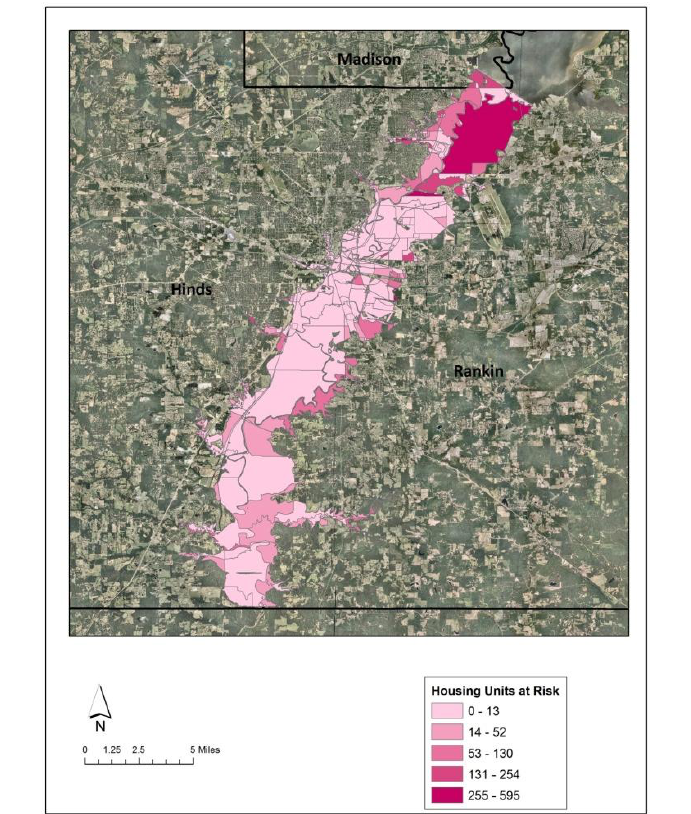
Figure 17. Number of housing units at flood risk downstream of Ross Barnett